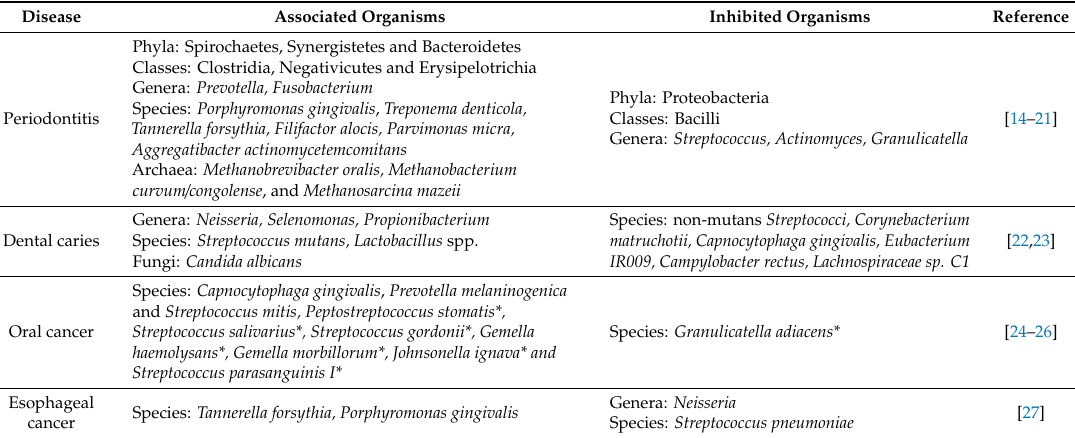
Table 1. Examples of metagenomic studies of associations between the oral microbiome and oral diseases. The first column indicates a disease, the second indicates organisms that have been found at higher abundances in individuals presenting with the disease, the third indicates organisms at lower abundances, and the fourth contains the references to the literature, which displays these findings. (*) indicates taxa associated with oral cancer from a study in which samples were from tumor and non-tumor sites in the same patients and disease treatment is not